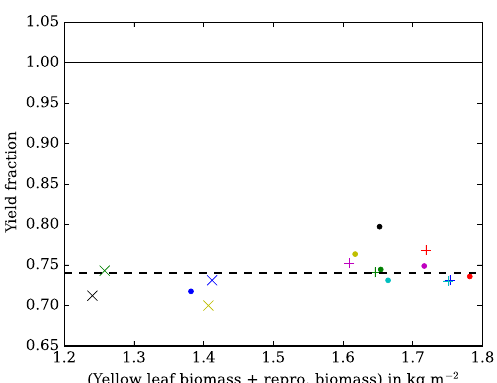
Figure 9. Yield fraction against the sum of the biomass in the re- productive parts of the maize crop (kernel, cob, husk, ear shank and silk) and the yellow leaf biomass, using the last measurement of the season. Dots, vertical crosses (+) and diagonal crosses (x) are US- Ne1, US-Ne2 and US-Ne3 observations respectively. Solid black line shows the value used implicitly in Osborne et al. (2015) and dashed black line shows the new, tuned value.